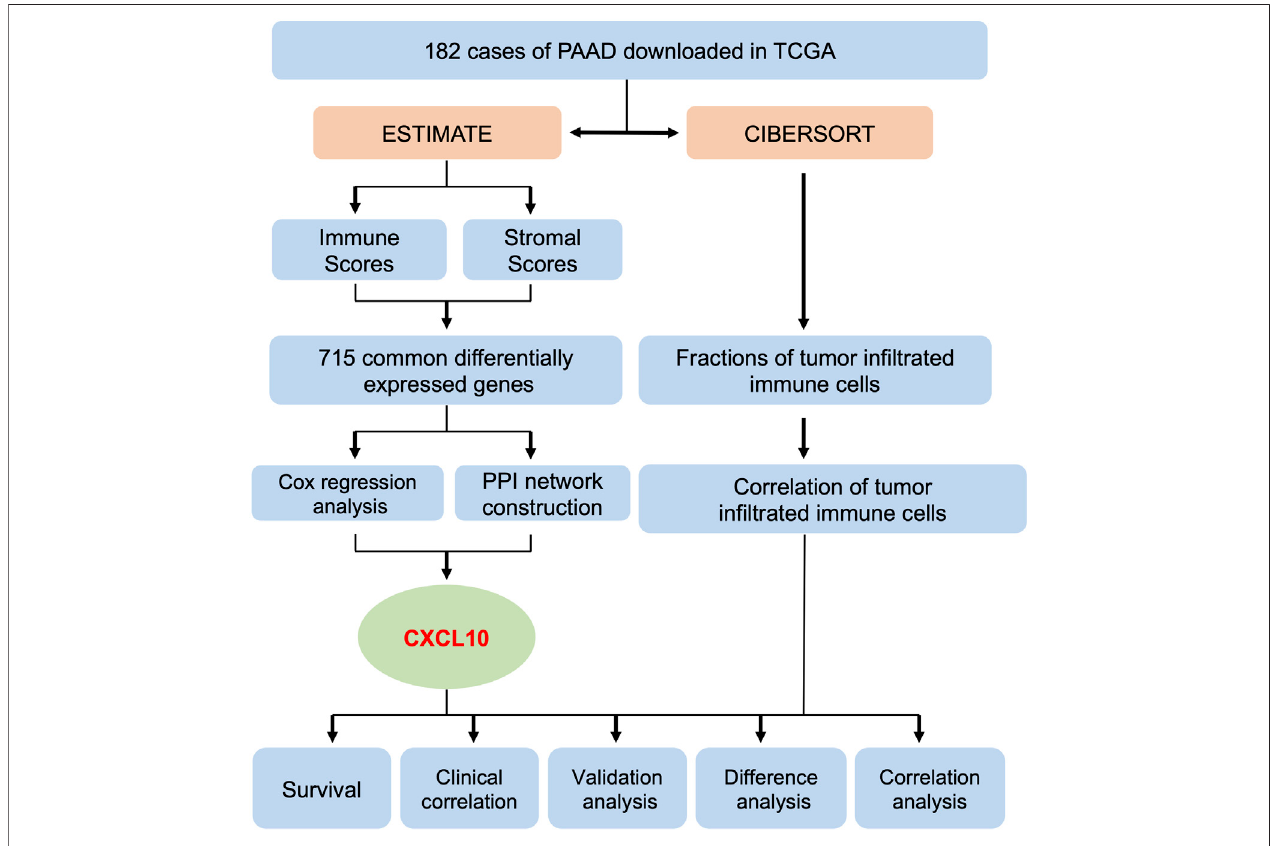
FIGURE 1 | Flowchart of the data analysis